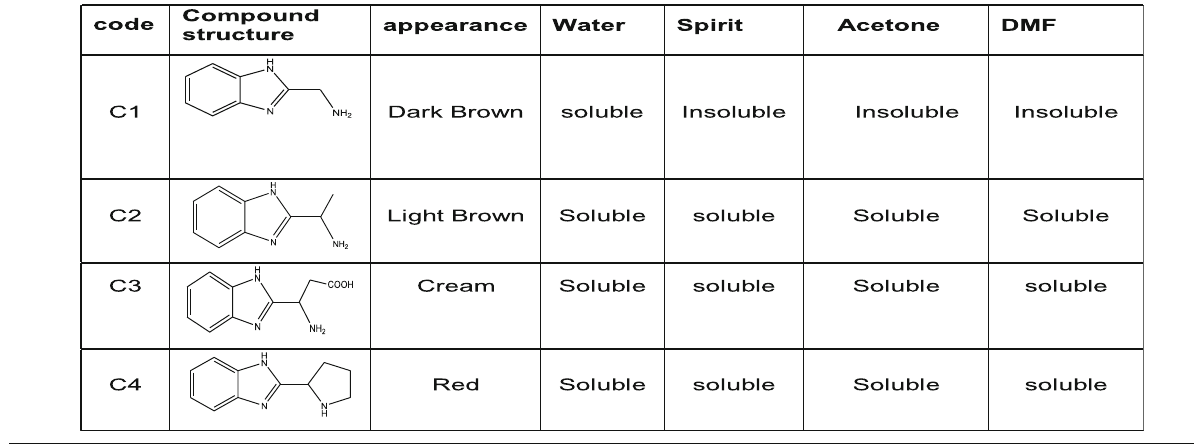
Table 4 Solubilities and appearance of synthesized